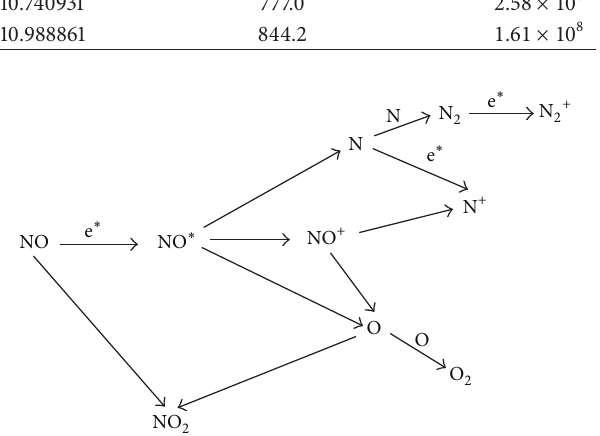
Figure 3: Diagram of main reaction paths and species during discharge.